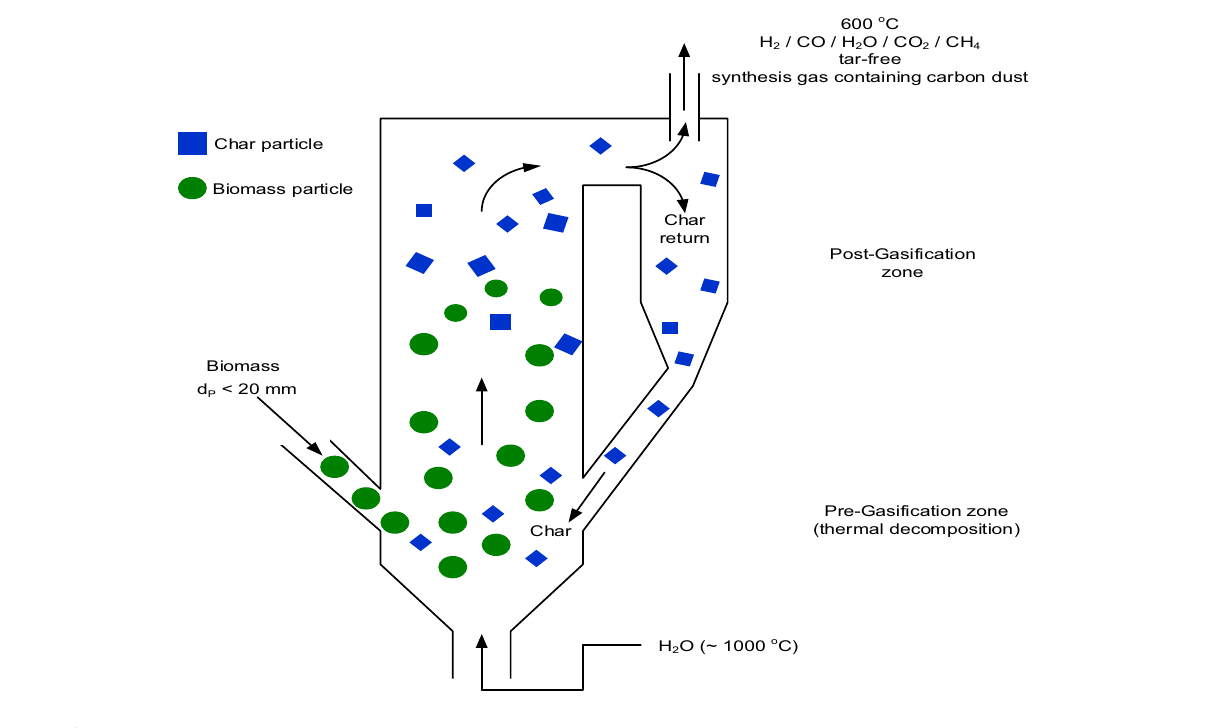
FIGURE 2 | Schematic of gasification chamber